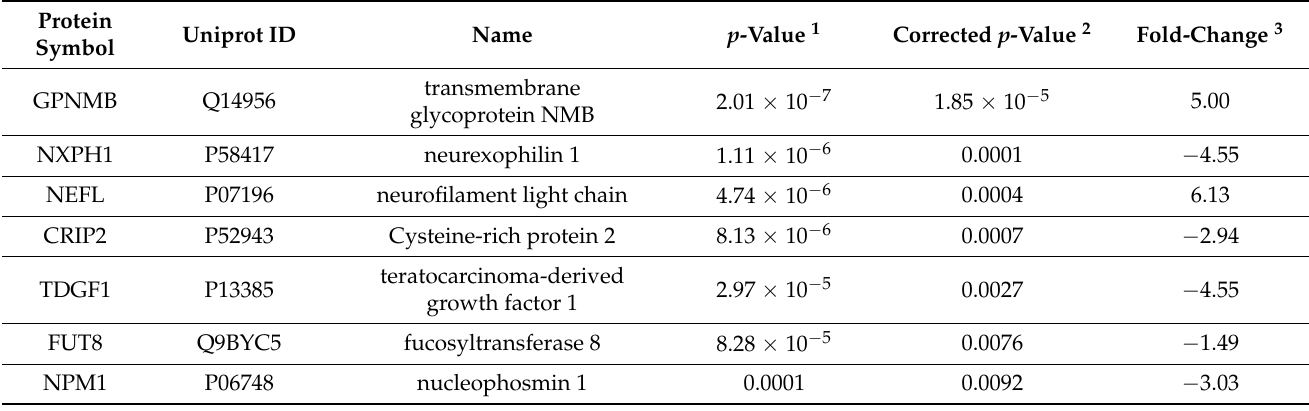
Table 2. Most significantly changed CSF proteins between CALD and control patients identified on the Olink Neurology Exploratory